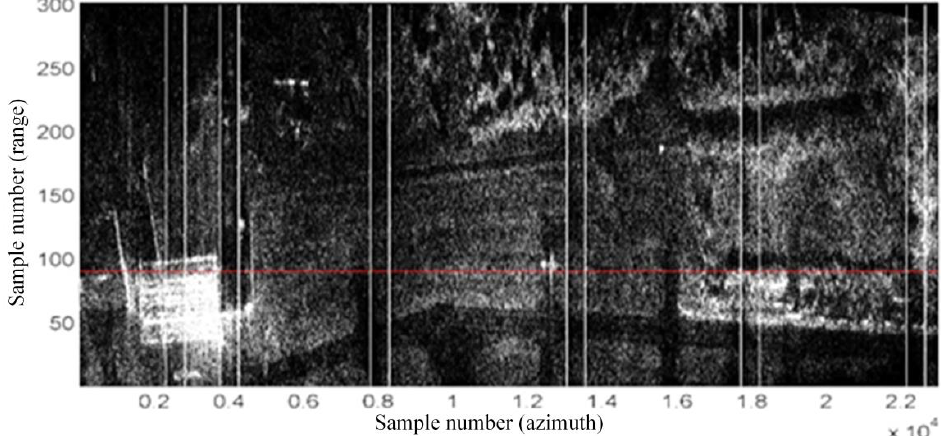
Figure 15. Radar terrain image obtained using MINS-based MOCO. Overlap bounds are marked white, whereas the red line is an image line chosen to determine SR, PSLR, and ISLR.